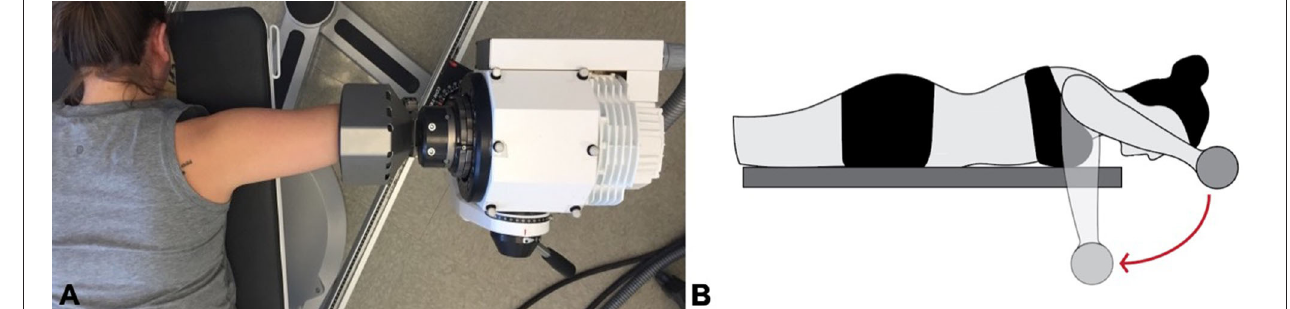
FIGURE 1 | (A) Participant setup on the isokinetic dynamometer. (B) Movement pattern of the shoulder internal rotation fatigue protocol.